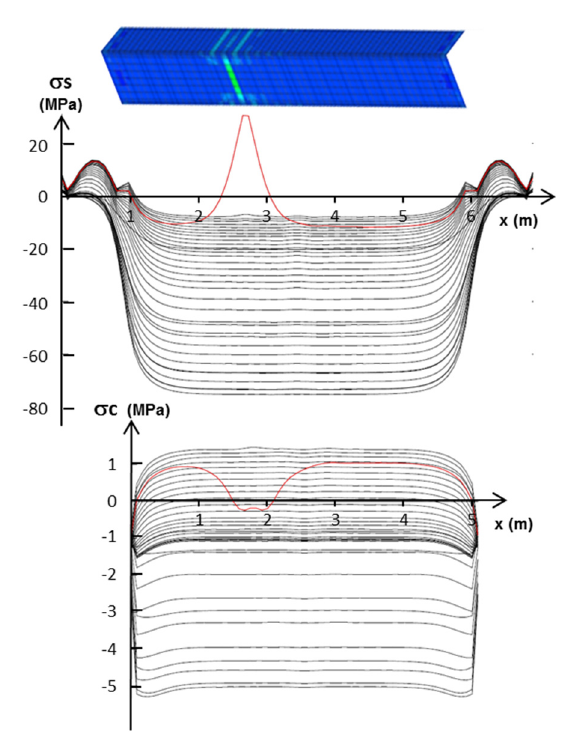
Figure 14. Stress profiles along the tie length (VS 2%) in the reinforcement and in concrete over time (red curves obtained at the 1st crack occurrence, 56 h after